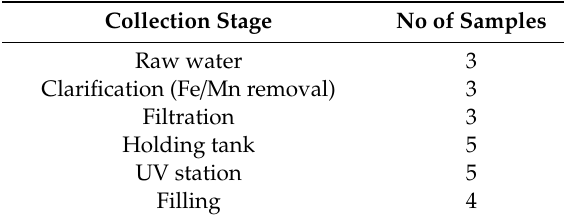
Table 1. Processed water samples used in the research.